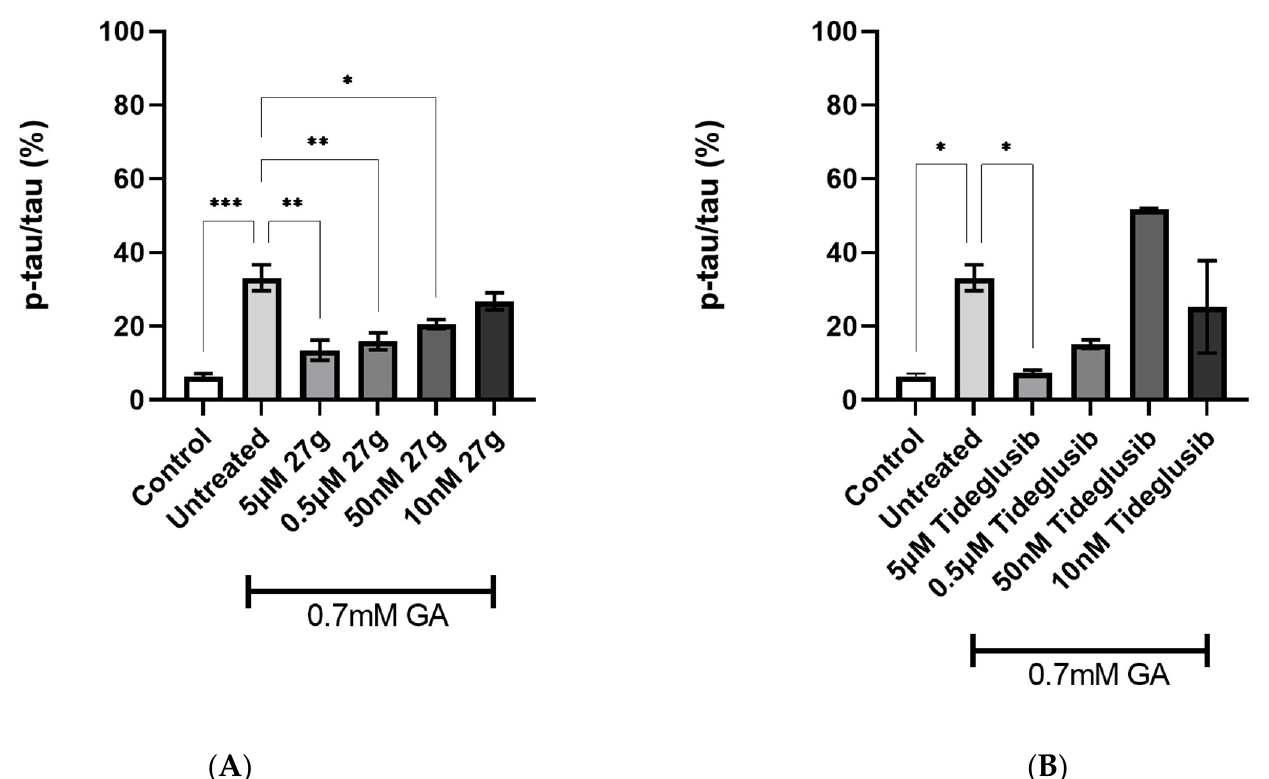
Figure 7. Reduction of Tau S199 phosphorylation after 27g treatment in 0.7 mM GA-exposed neurons. ( A ) Quantification of phosphorylation ratio pTau/tTau on S199 of 0.7 mM GA-treated SH-SY5Y-differentiated neurons after 27g treatment. ( B ) Quantification of phosphorylation ratio pTau/tTau on S199 of 0.7 mM GA-treated SH-SY5Y-differentiated neurons after Tideglusib treatment. Kruskal–Wallis test followed by Dunn’s post-hoc was used to compare the differences between different groups. Data are expressed as mean ± SEM, n = 3 with at least 5 repetitions per experiment, * p < 0.05; ** p < 0.01, *** p < 0.001.